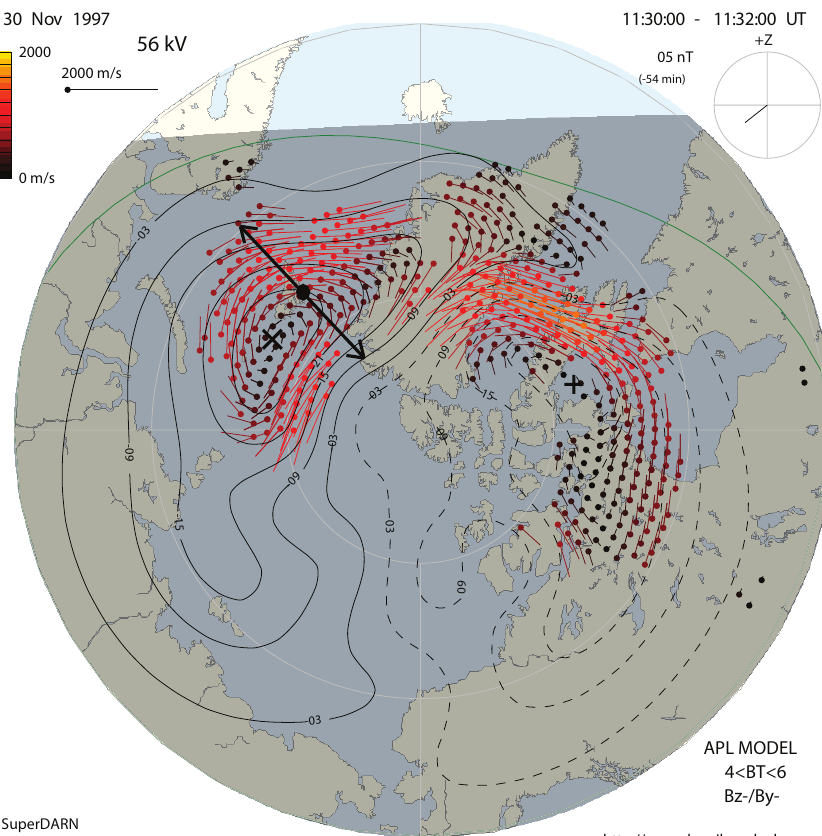
Fig. 4. Plasma convection pattern for 11:30–11:32 UT as obtained from SuperDARN radars. The coordinate system is MLAT/MLT. Ion drift velocities are color coded according to the scale in the upper left corner. The IMF orientation projected to the GSM Y-Z plane is given in the upper right corner. The FOV of the MSP in Ny ˚Alesund at 11:30 UT (along 15:00 MLT meridian) is marked by a double-arrowed meridional line.